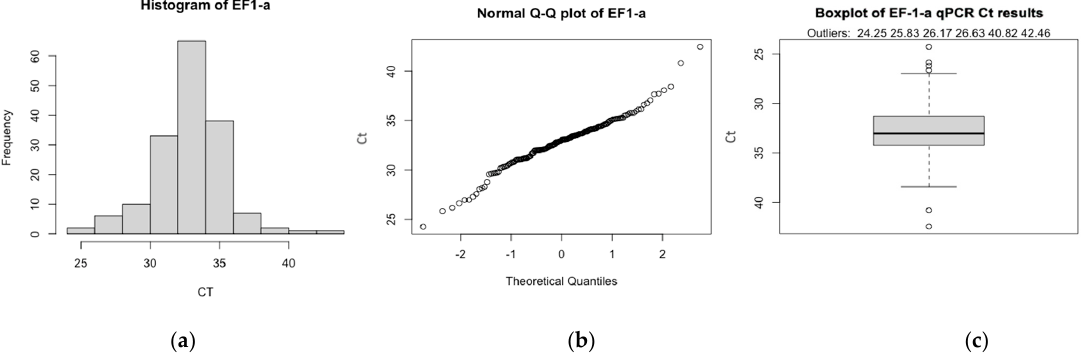
Figure A1. The ( a ) histogram, ( b ) normal Q–Q plot and, ( c ) box plot of EF–1– α Cts. Both the histogram and normal Q–Q plot exhibited an approximately normal distribution via a bell-shaped curve and alignment of data along the diagonal line, respectively. There were six EF–1– α outliers, one of which detected EEHV 1a/b (26.63 EF–1– α Cts and 37 EEHV 1a/b Cts, from Cow 4 collected on 2 November 2019). For the box plot, the y-axis is inverted to visually represent the inverse relationship between qPCR Cts and gene expression. As determined by a Shapiro–Wilk test, there was evidence to suggest EF–1– α Cts were not normally distributed ( p = 0.004).